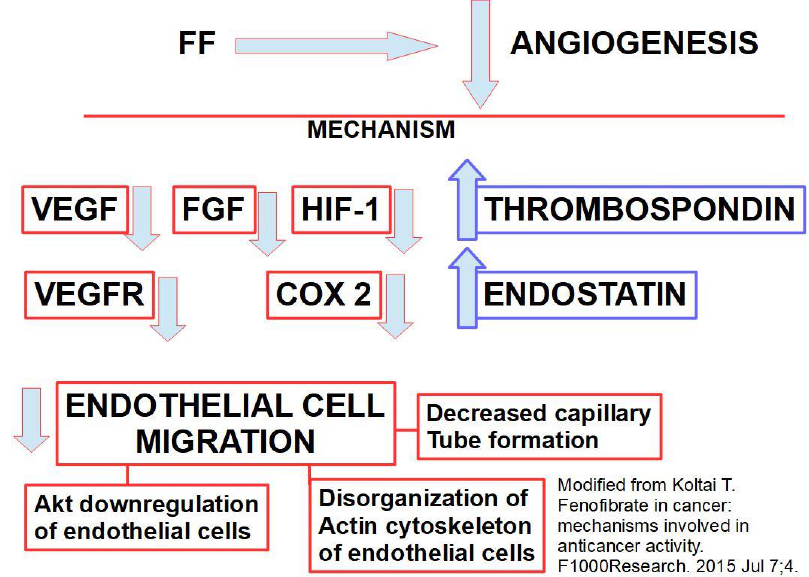
Figure 2. Anti-angiogenic mechanisms of Fenofibrate (FF) [113].